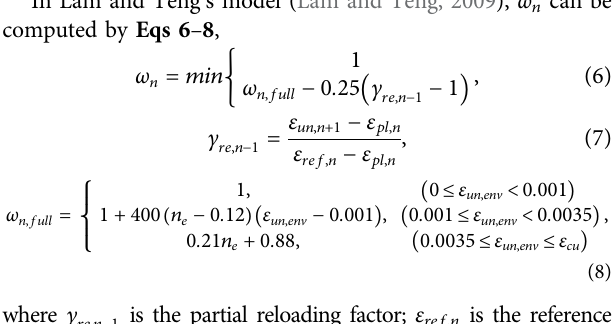
Frontiers in Materials |